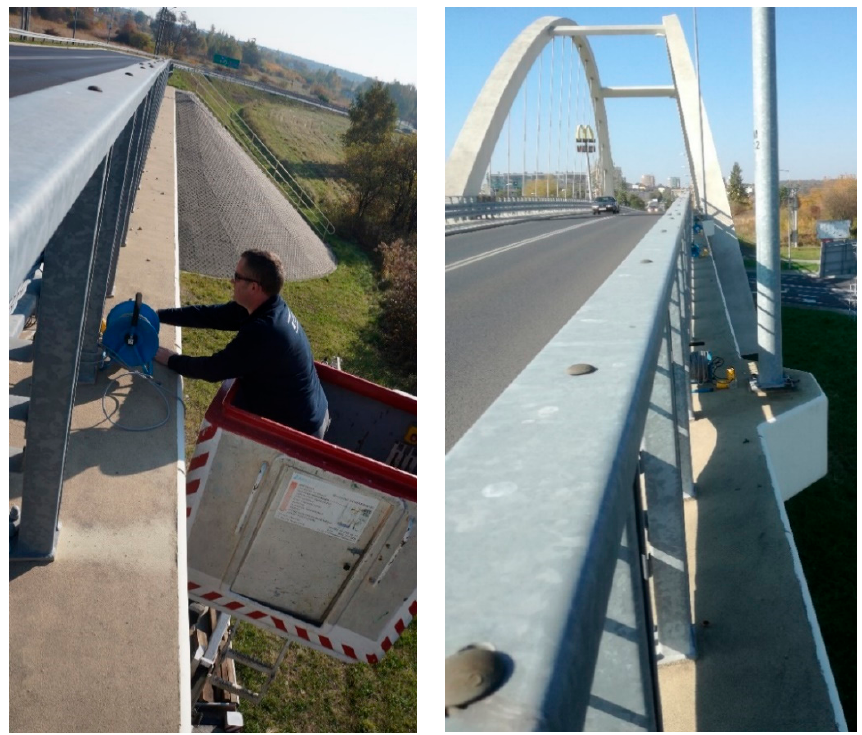
Figure 10. The mounting of accelerometers in the measurement points of the viaduct [45].